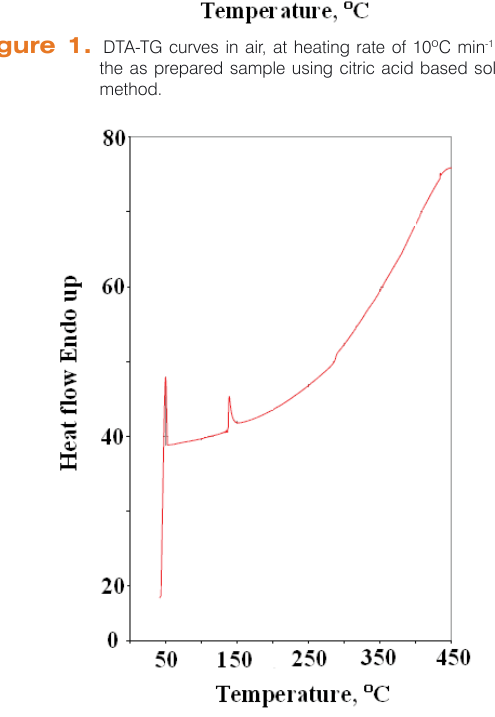
Figure 2. DSC curve in nitrogen, at heating rate of 5 o C min -1 , for the as prepared sample using citric acid based sol-gel